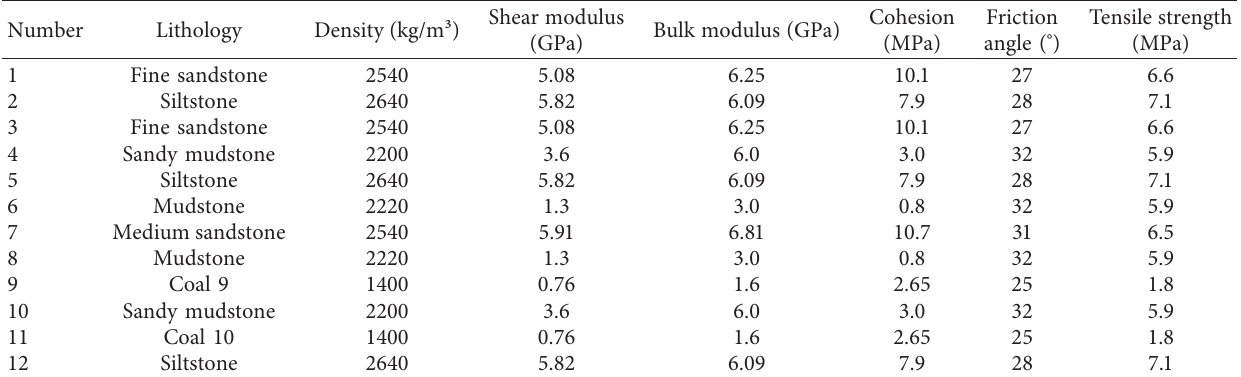
Figure 4: Processing equipment: (a) ZS-100 fully automatic drilling machine; (b) SCM200 double-end grinder; (c) HJD-150A concrete sawing machine; (d) SC200 automatic core-taking machine. Table 1: Mechanical properties of coal-rock